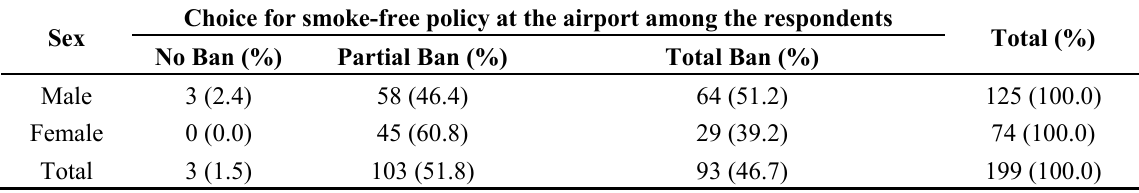
Table 3. Support for smoke-free policies among the respondents by